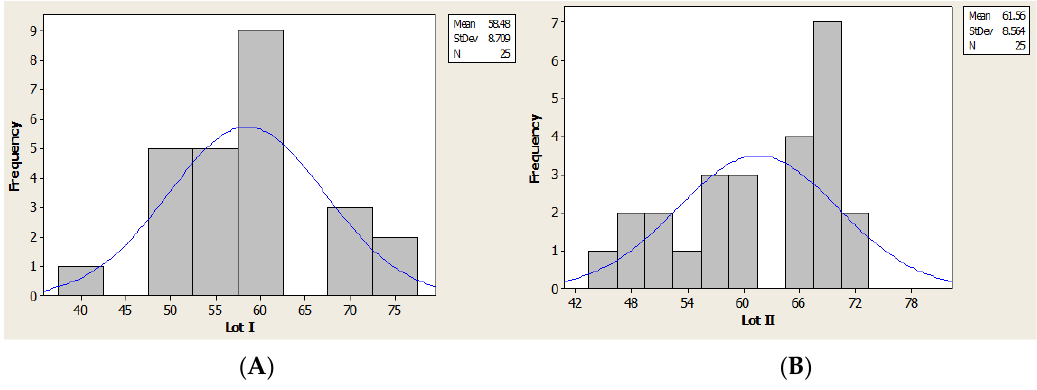
Figure 4. Age distribution (histogram): ( A ) lot I, ( B ) lot II. Clinical and Functional Results